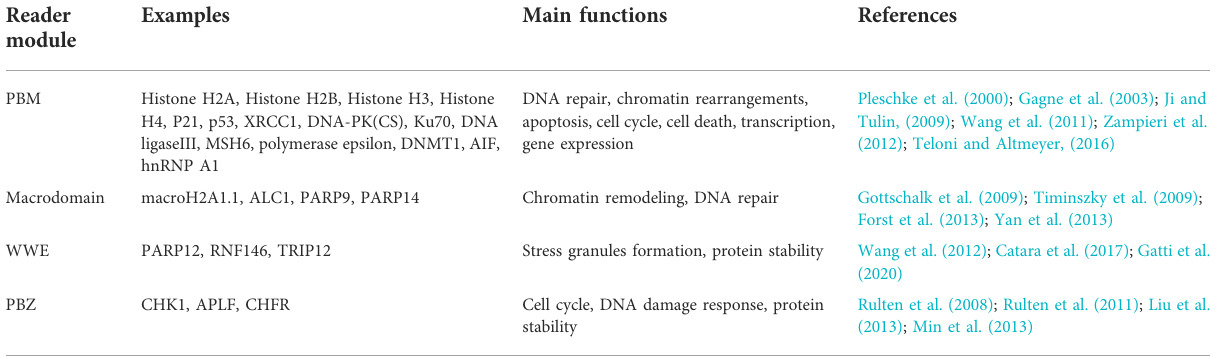
TABLE 1 Summary of ADP-ribosylation